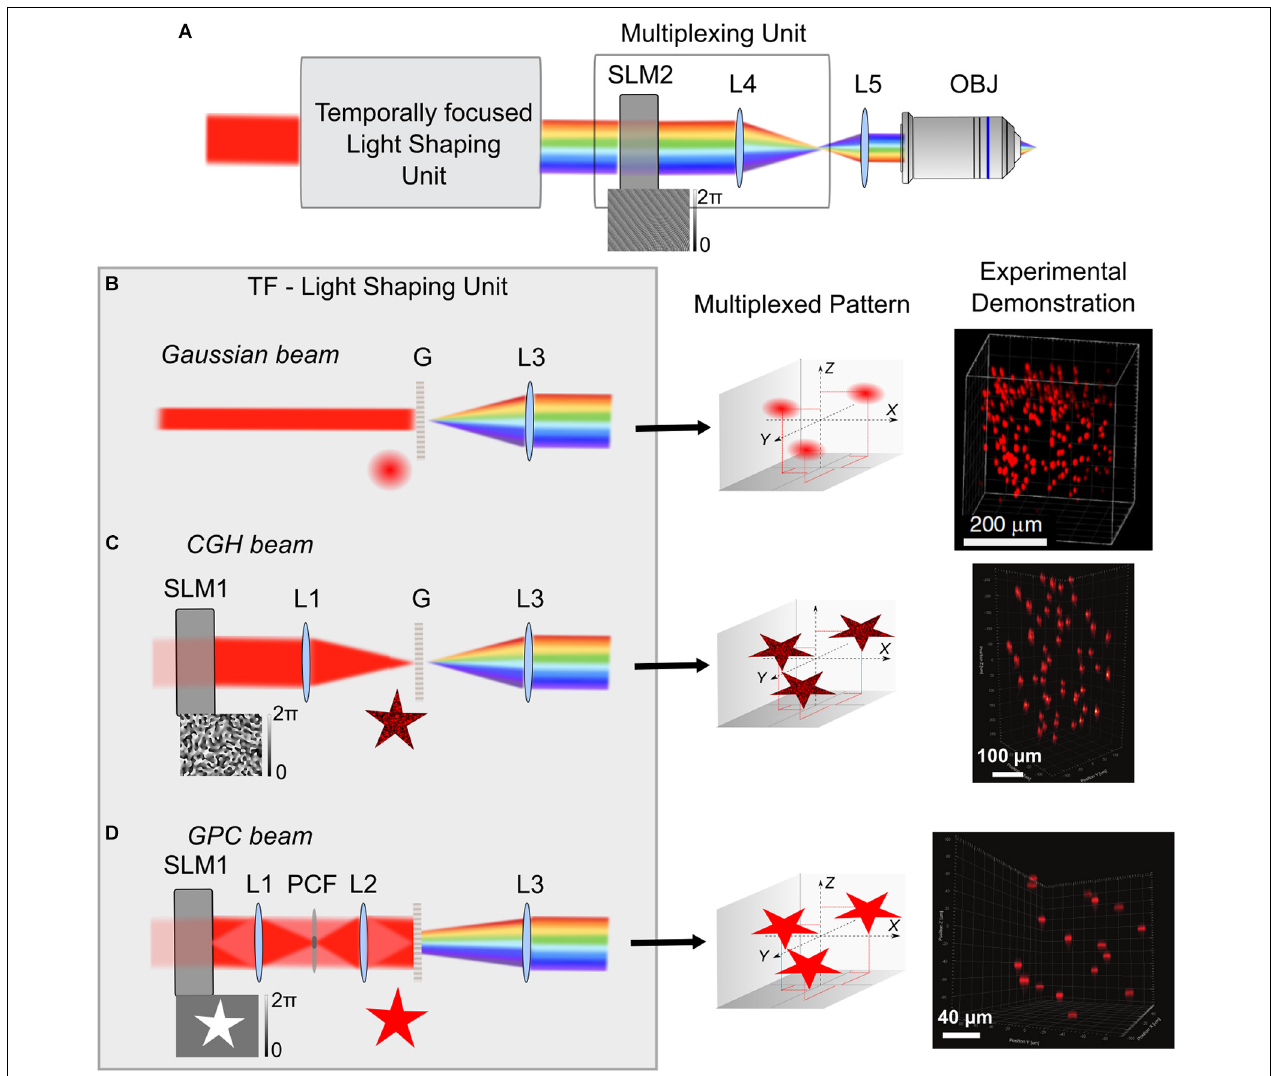
FIGURE 2 | 3D multiplexed temporally focused light shaping. (A) Optical systems for 3D temporally focused light shaping consist of a light-shaping unit for creating a 2D temporally focused pattern and a multiplexing unit, using a SLM (SLM2) at a Fourier plane of the TF system, to replicate the 2D pattern in several positions in 3D via 3D-CGH (example of a phase profile for projecting 3 diffraction-limited spots in different positions is shown on the bottom of SLM2). After the light-shaping unit, the beam is represented with its spectral frequencies diffracted, because of spectral diffraction by the grating G. After phase modulation on SLM2 the beam is imaged by two lenses (here L4 and L5) to the back aperture of the microscope objective. (B–D) Different cases for the TF-light-shaping unit: (B) Gaussian beam. In this case the grating is illuminated with a collimated Gaussian beam of a suitable size, usually adjusted with a telescope of lenses (not shown here). Configuration with a non-collimated beam (by introducing a lens prior to the grating) was used by Pégard et al. (2017) in order to increase the illuminated area of SLM2. Middle. Illustration of the example for projection of 3 Gaussian replicas, when the SLM2 is illuminated with the phase profile shown in A . Right. Experimental demonstration showing projection of 200 Gaussian beams in a 350 × 350 × 280 µ m 3 volume, adapted from Pégard et al. (2017). (C) CGH beam. A SLM (SLM1) and a lens (L1) are used for holographic pattern projection (here, a star), that is then replicated in the 3 different positions (Middle). Right. Experimental demonstration of 50 holographic circular spots of 15 µ m diameter in a 300 × 300 × 500 µ m 3 volume, adapted from Accanto et al. (2018). (D) GPC beam. SLM1 is used for a binary phase modulation of (cid:49) ϕ = π , that is then phase contrasted by the phase contrast filter (PCF), placed at the focal plane of L1. A sharp speckle-free pattern is formed at the grating plane by L2. Middle. 3 replicas for the GPC pattern in the corresponding predefined positions of the multiplexing unit. Right. Experimental demonstration of projection of 17, 12- µ m diameter circular GPC spots in a 200 × 200 × 200 µ m 3 volume, adapted from Accanto et al. (2018). L3 Collimating